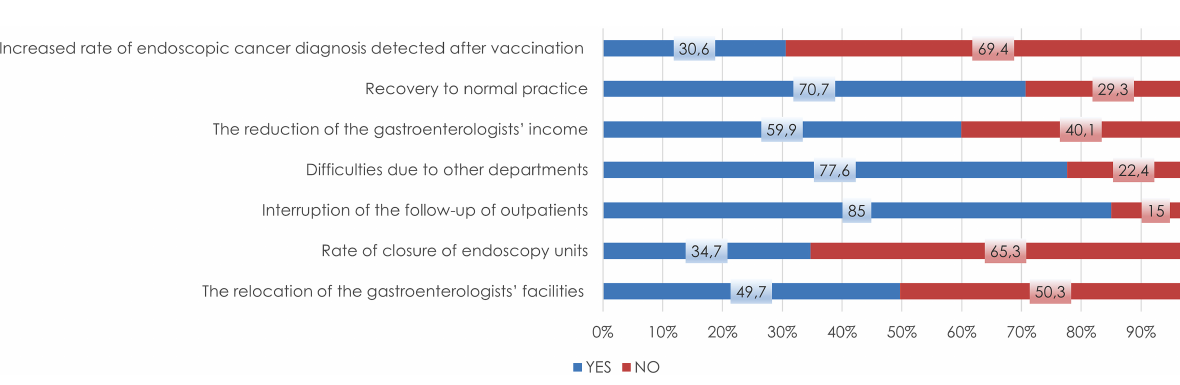
(Figure 1). Inflammatory bowel disease and chronic viral hepatitis compromised most of these patients (Figure 2).